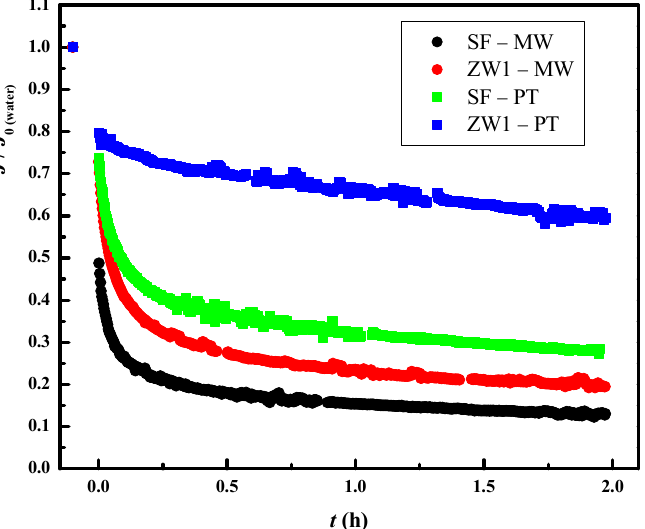
Figure 3. Normalized fluxes ( J / J 0(water) ) of SF and ZW1 pretreatments with PT and MW membranes.